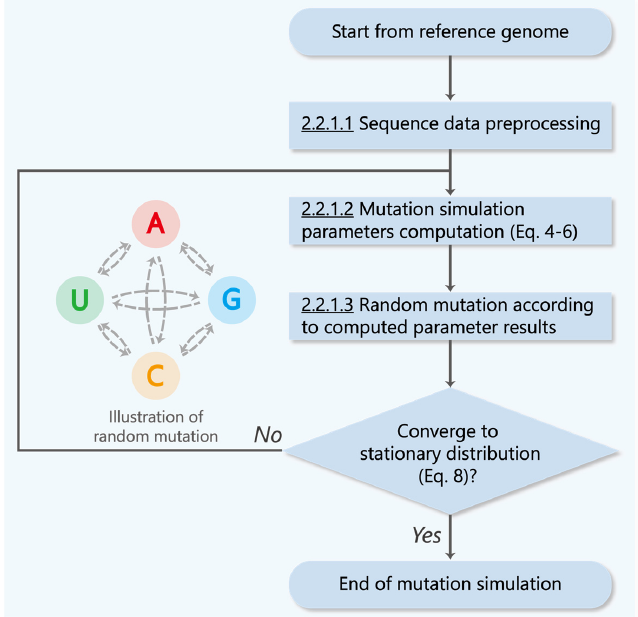
Figure 3. The mutation simulation flowchart of SARS-CoV-2. Mutation Simulation Parameters Computation